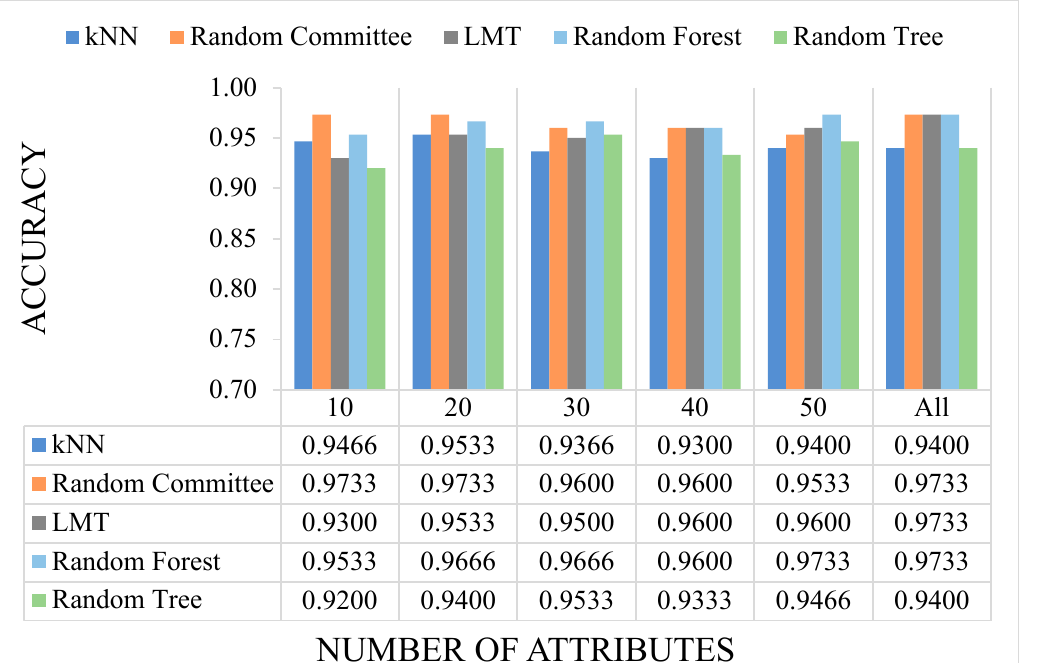
Figure 8. The accuracy results of the ML models on cancer stage classification with different num- bers of attributes. (Illustrations by the authors) .